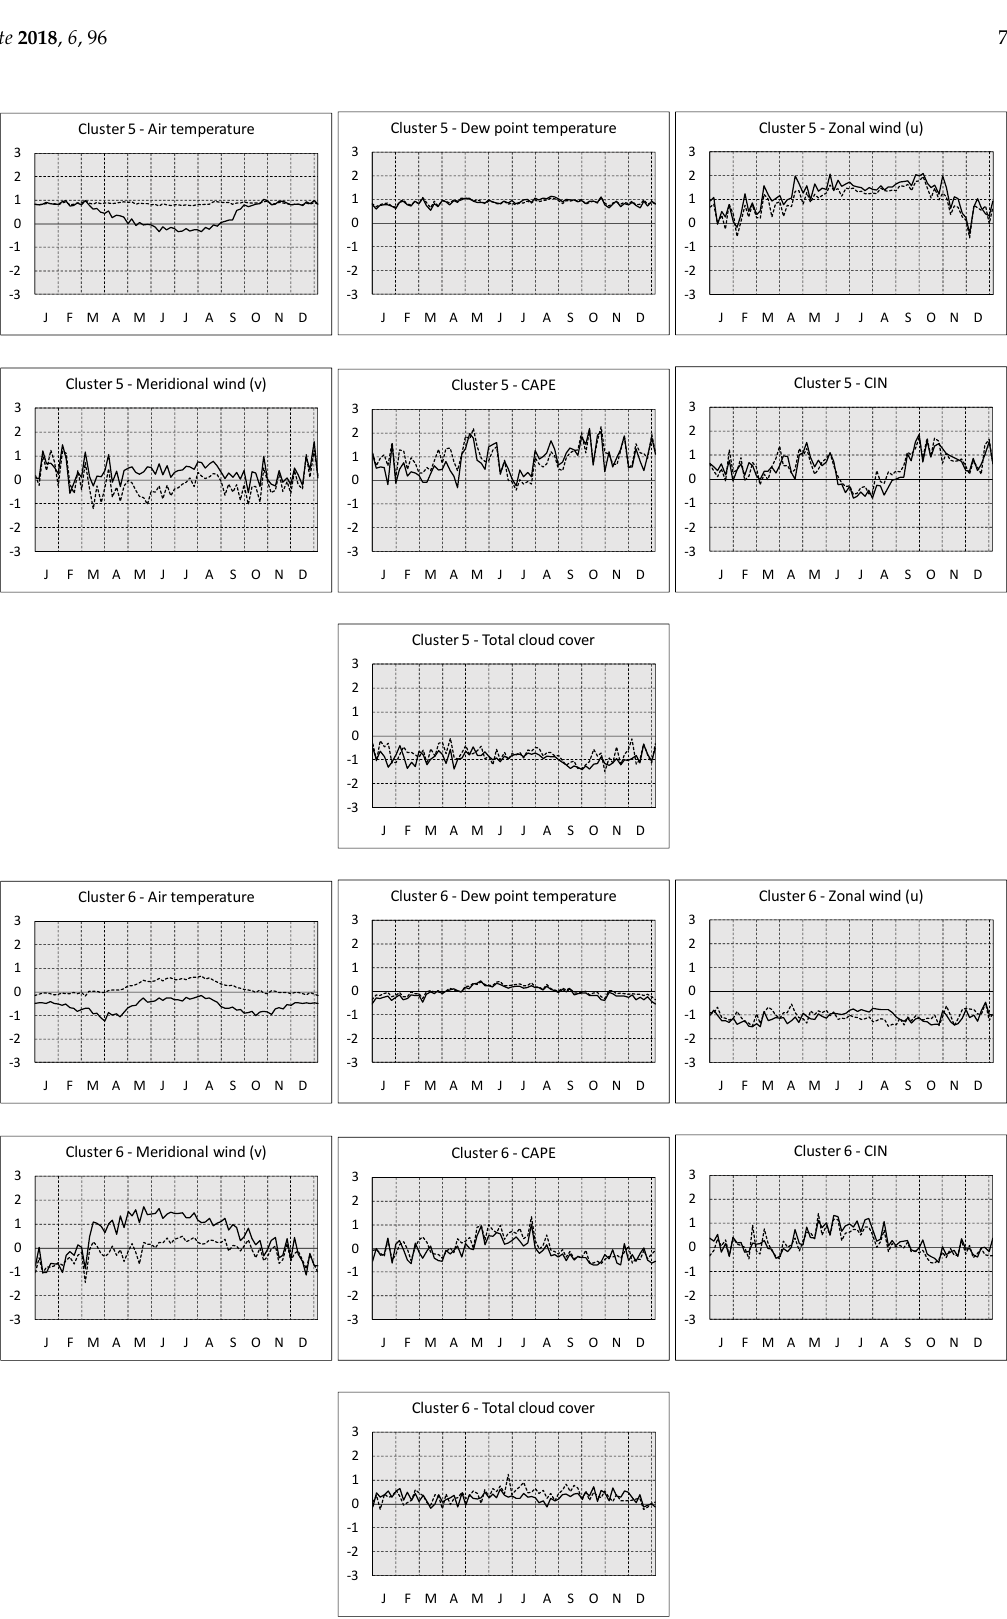
Figure 6. As in Figure 4, but for clusters 5 and 6.